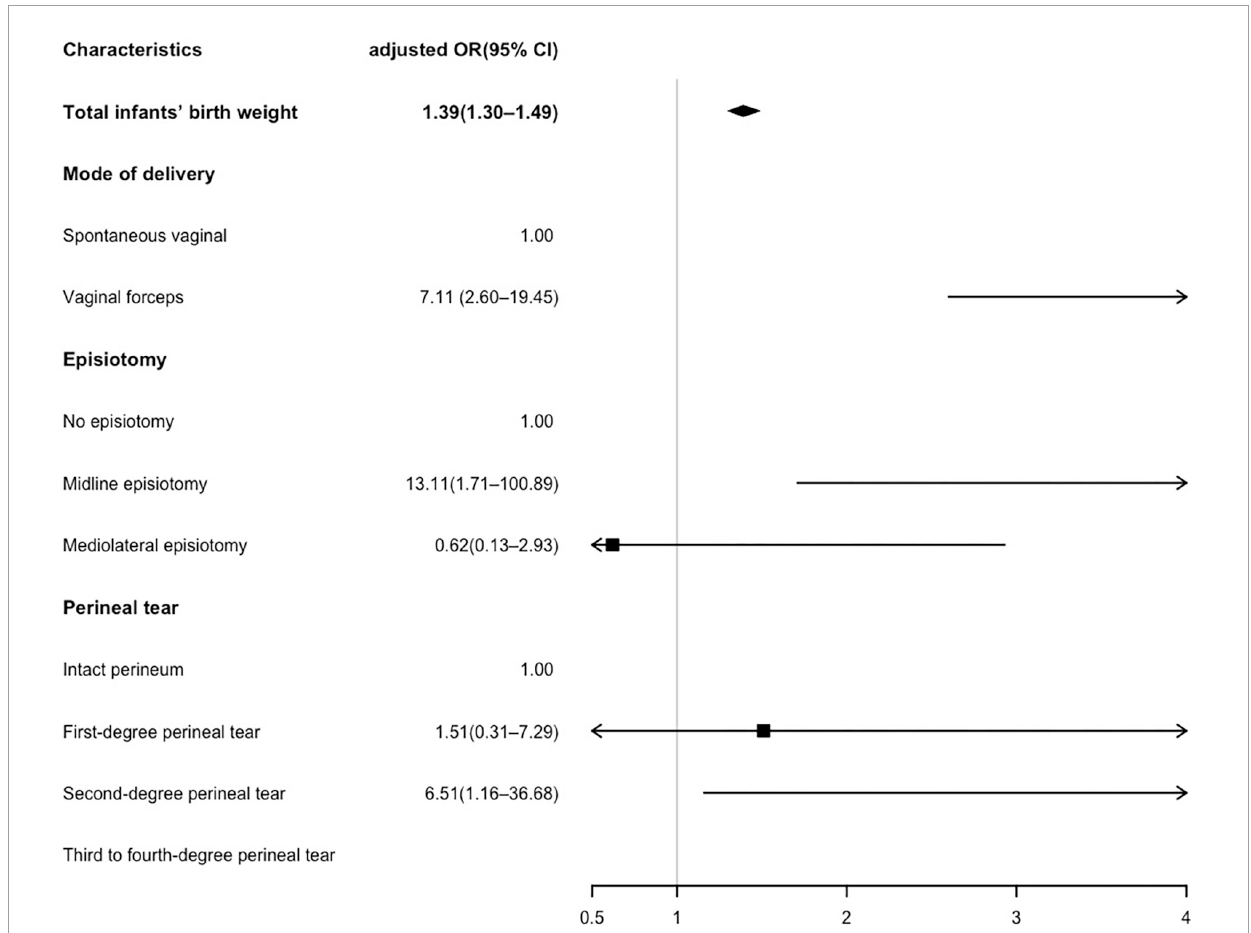
FIGURE2 Multivariate logistic analysis of risk factors associated with anal incontinence (AI). Maternal age, body mass index (BMI), abnormal occiput position and parity were adjusted in the logistic regression model. The unit of total infants’ birth weight is 100